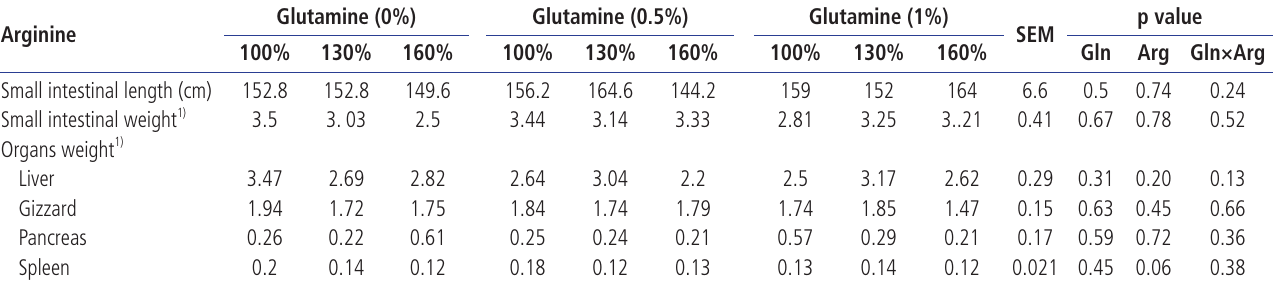
Table 4. The effects of dietary supplementation with Glutamine (Gln) and Arginine (Arg) on length, proportional weight of small intestine, and proportional weight of visceral organs in broiler reared under cold environmental condition Glutamine (0%) Arginine Small intestinal length (cm) Small intestinal weight 1) Organs weight 1) Liver Pancreas